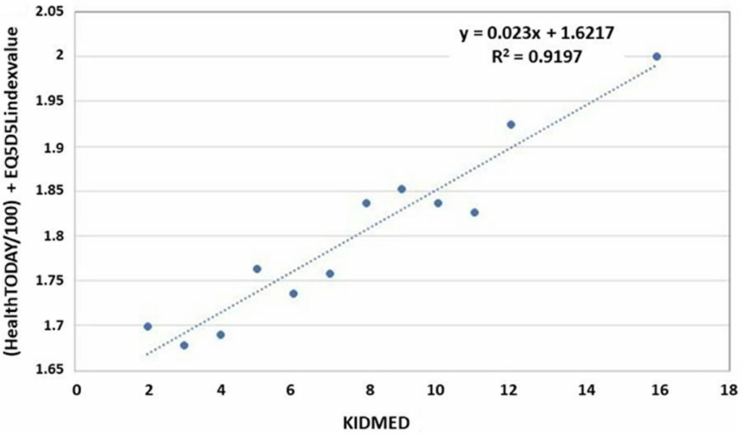
Figure 2. Correlation between health-related quality of life and adherence to the Mediterranean diet. Table 4. Fitness status of children according to health-related quality of